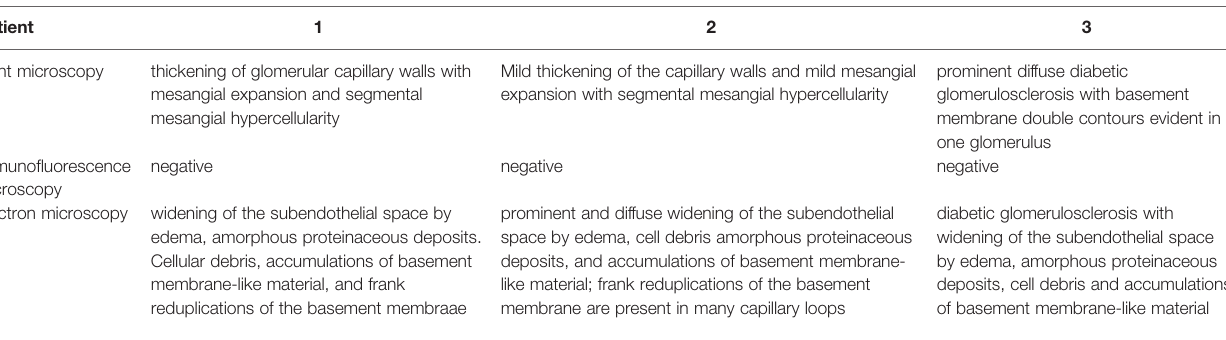
TABLE 4 | Pathology of kidney biopsy.